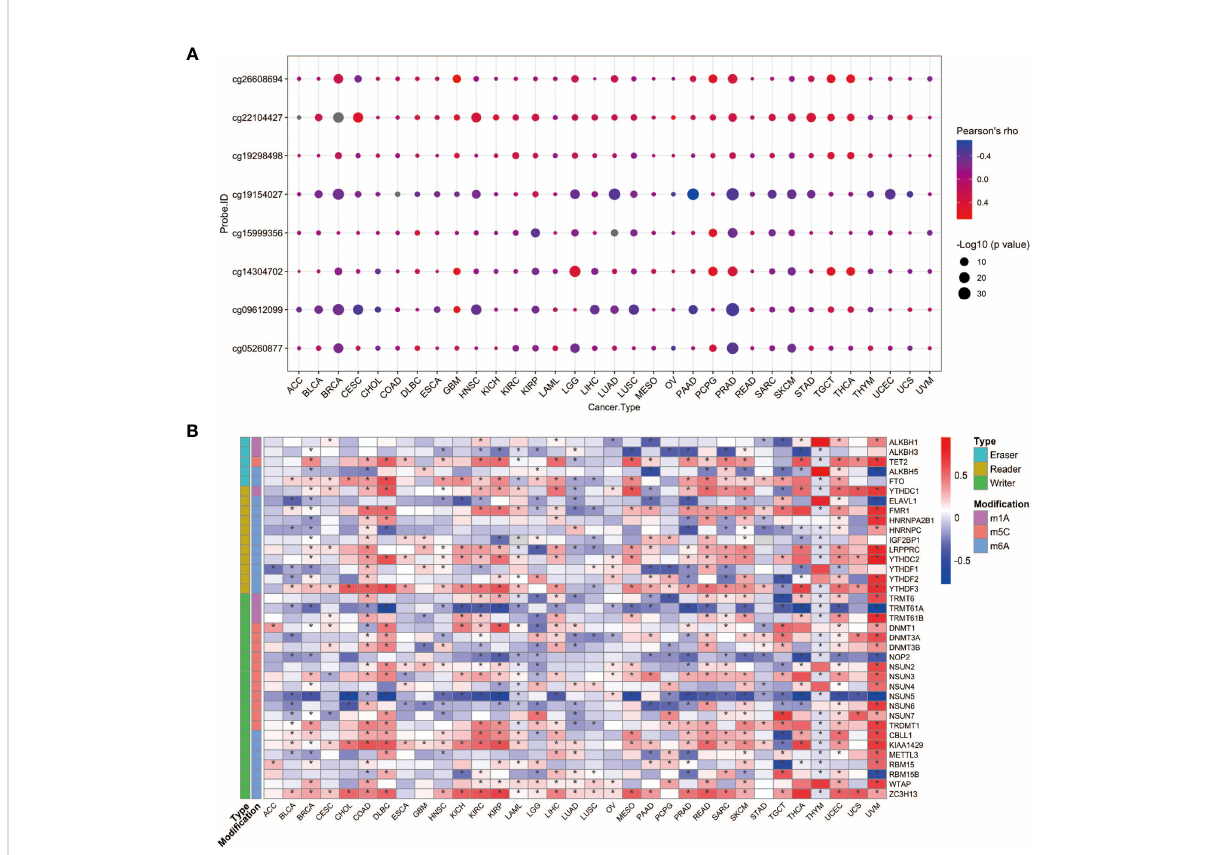
FIGURE 2 YAP1 expression correlates with its DNA methylation and RNA modi fi cation. (A) Pearson correlation between YAP1 expression and its DNA methylation in 33 cancer types. (B) Pearson correlation between YAP1 expression and RNA modi fi cation regulators. *p <